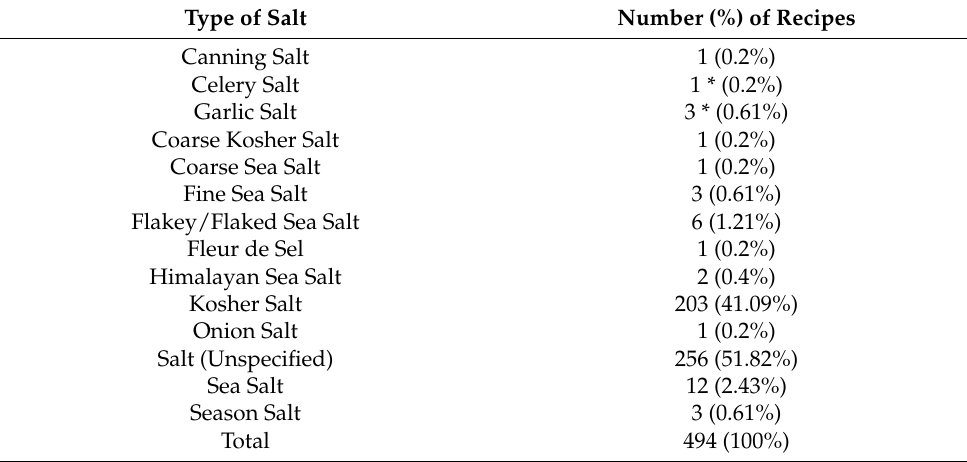
Table 3. Number of recipes by the type of salt included in the ingredient list in eight magazines published between 2019 and 2021.